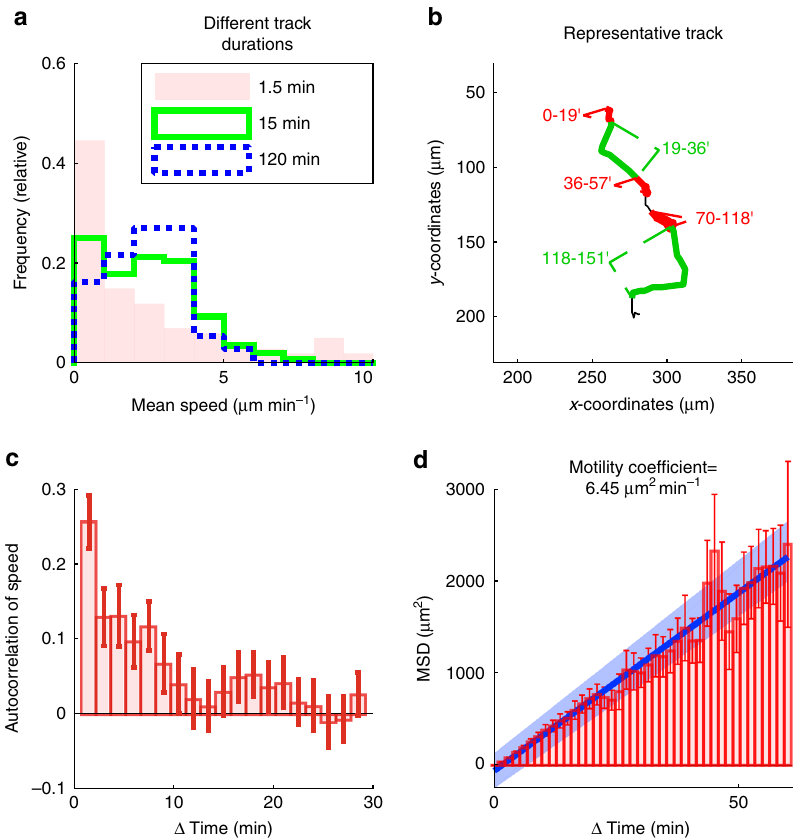
Fig. 2 Lung in fi ltrating T cells move over a wide range of speeds. GFP + effector T cells were injected i.v. into LPS-treated mice. After two to fi ve days, lungs were explanted and imaged with two-photon microscopy. Tracks with a duration of 120 min were analyzed. a Shown are the average speeds of complete 120 min ‘‘ parent ’’ tracks ( n = 37 tracks), and of 15 min ( n = 259 tracks) and 1.5 min ( n = 2923 tracks) track ‘‘ children ’’ . b Representative T cell track with multiple transitions between ‘‘ fast ’’ ( green segments ) and ‘‘ slow ’’ migration ( red segments ). Numbers indicate time in minutes. c Autocorrelation of speeds. Means of 37 tracks (+/ − standard error of the mean). d The mean squared displacements (MSD) of 37 tracks (+/ − standard error of the mean). The blue line and shaded area show the linear regression with con fi dence interval. All quantitative analyses were performed on pooled data obtained from three independent